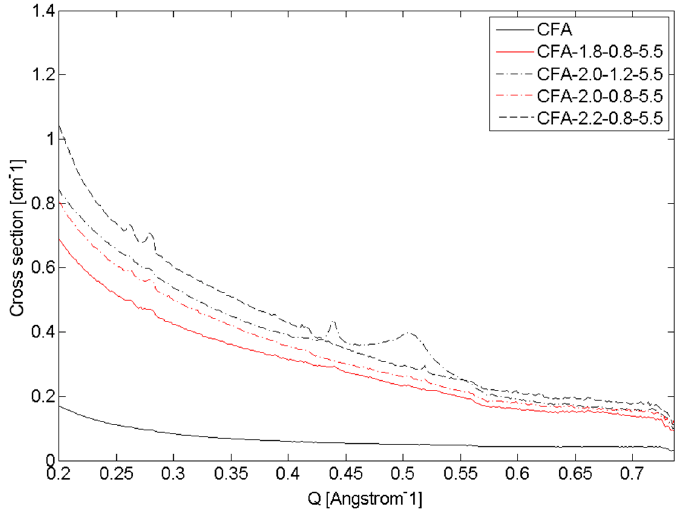
Figure 2. SAXS patterns confirm that the increased intensity at low angle (<3° 2 θ ) seen in the WAXS data is from small angle scattering phenomenon rather than a broad Bragg peak of a large zeolite-like phase. Collie Flyash (CFA) is also shown a comparison. The useful limit of the WAXS data was Q = 0.18 Å − 1 . Although there are Bragg peaks in the SAXS data, they are not source of the majority of the intensity. Note, cross section is a calibrated representation of intensity.